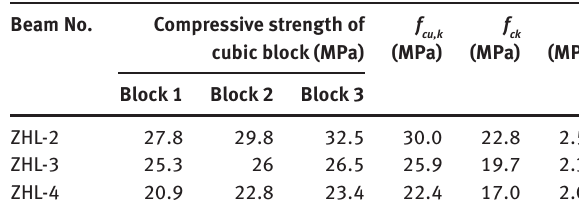
Table 1: The strength of the cubic concrete block of a transfer beam specimen.